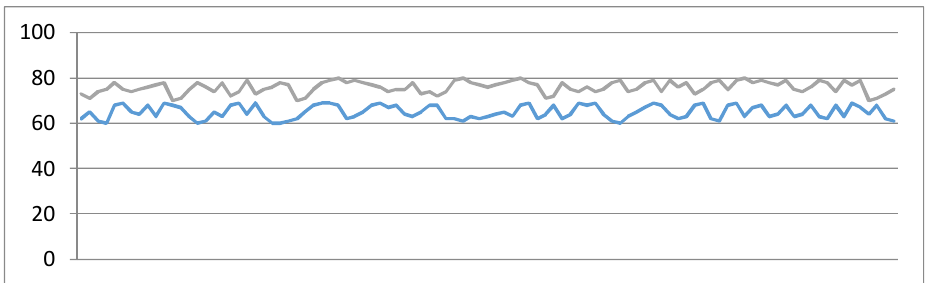
Fig. 2. The Comparison of before and after Compliance Tax